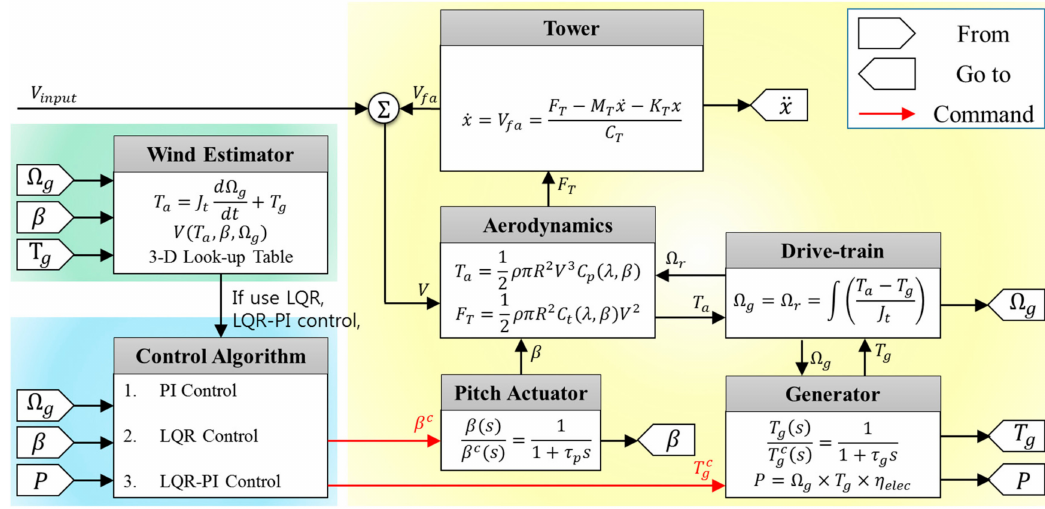
Figure 2. Block diagram of the in-house